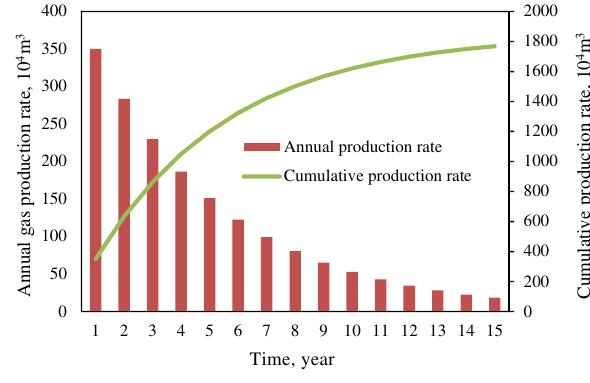
Fig. 2 Prediction of sidetracking well production and cumulative pro-